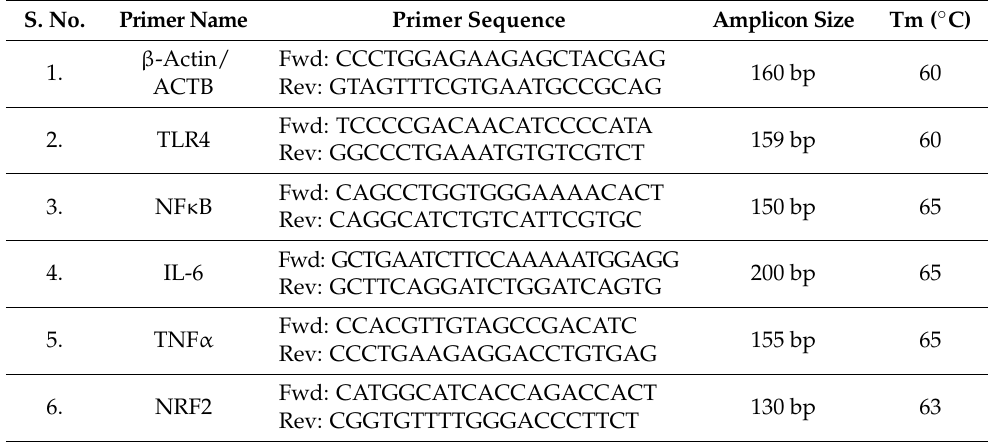
Table 1. Melting temperature and amplicon size of the primers